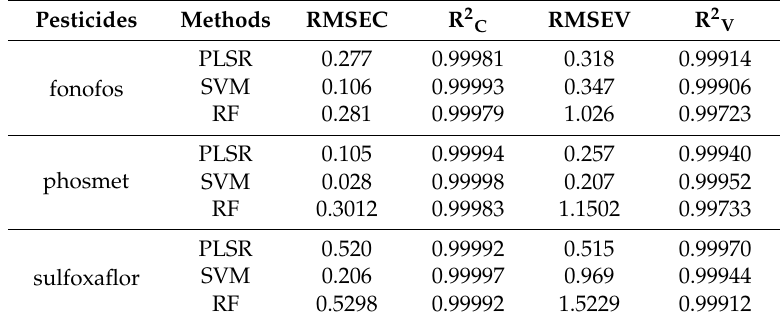
Table 2. The quantitation of pesticides in paddy water using the models developed by PLSR, SVM, and RF.